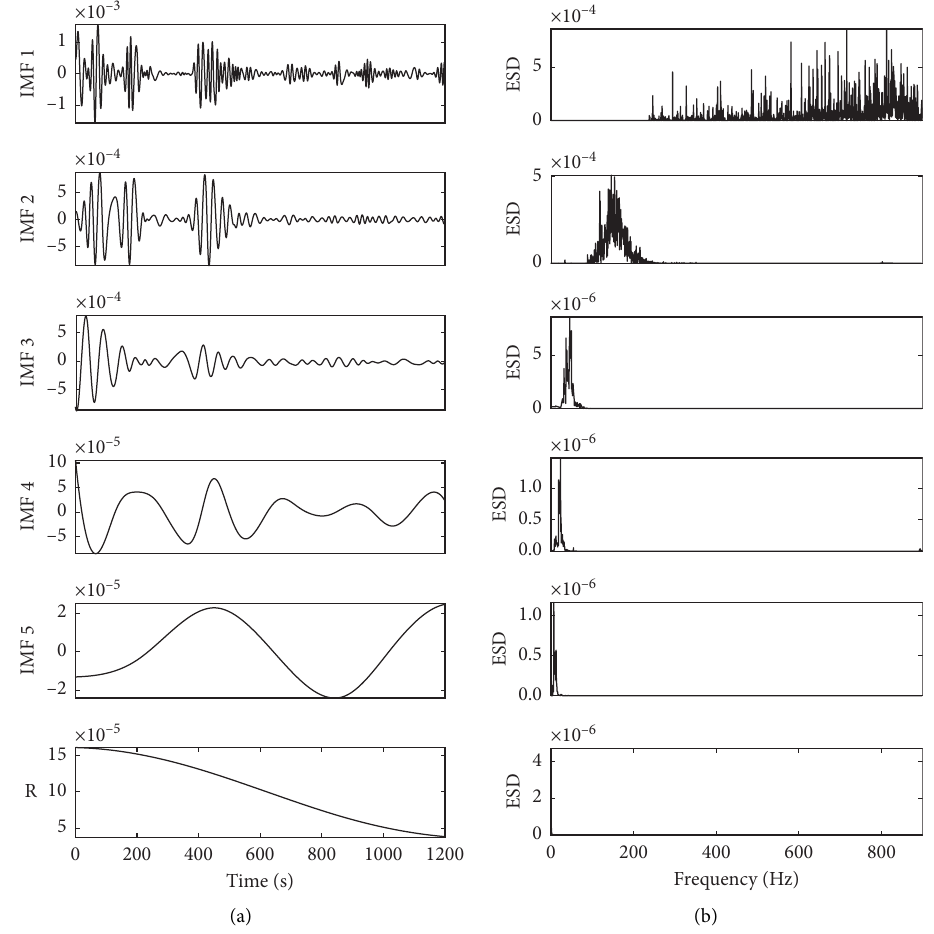
Figure 8: Results of CEEMD-MPE-HT time-frequency analysis. (a) Decomposition results of EMD. (b) IMF marginal spectrum.